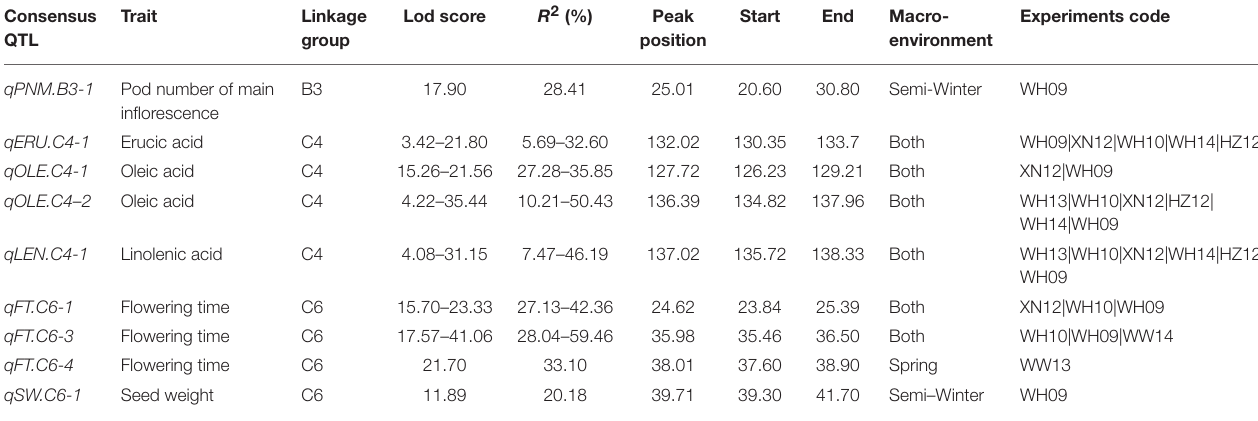
TABLE 4 | Major QTL accounting for the seed and oil quality traits in the YW DH